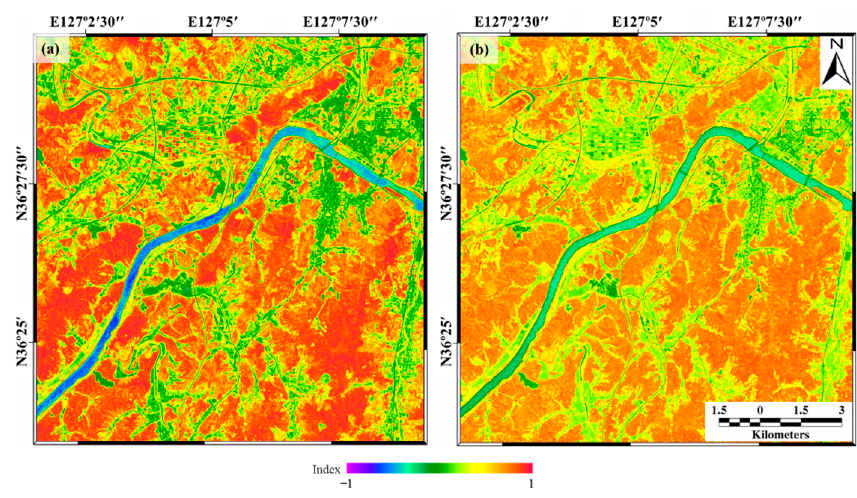
Figure 6. Input neurons of NDVI created from Sentinel-2 image: ( a ) spring and ( b ) fall season.